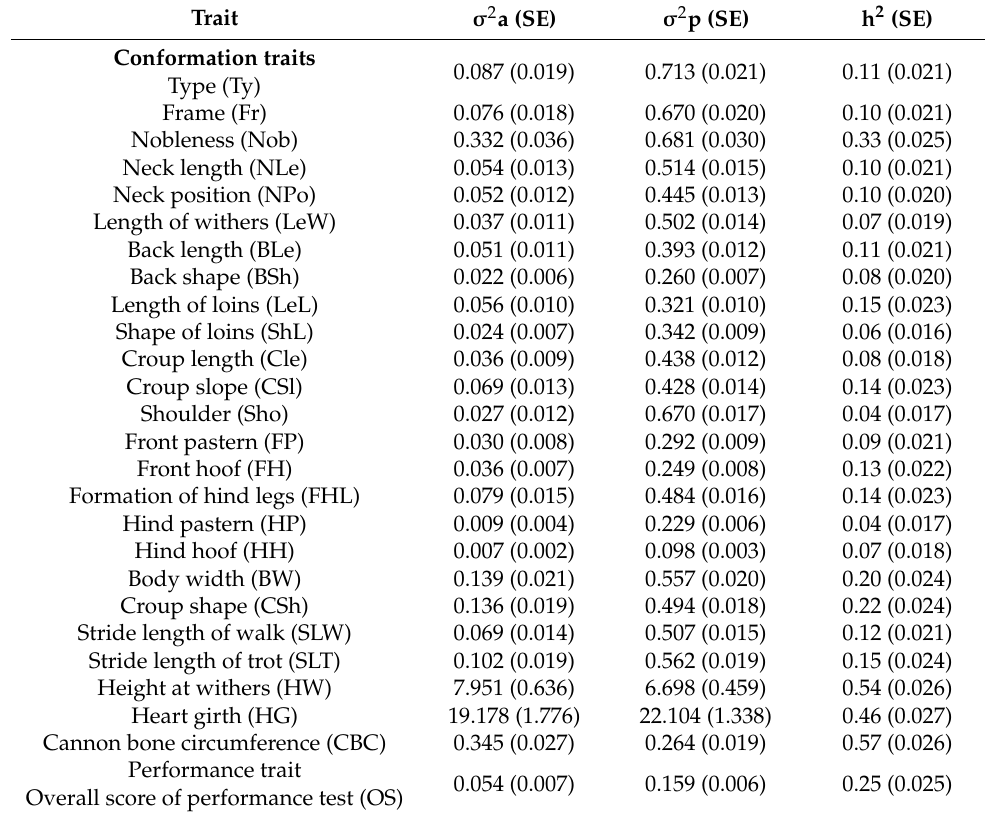
Table 3. Estimated genetic ( σ 2 a) and phenotypic ( σ 2 p) variance and heritability (h 2 ) obtained from the single-trait